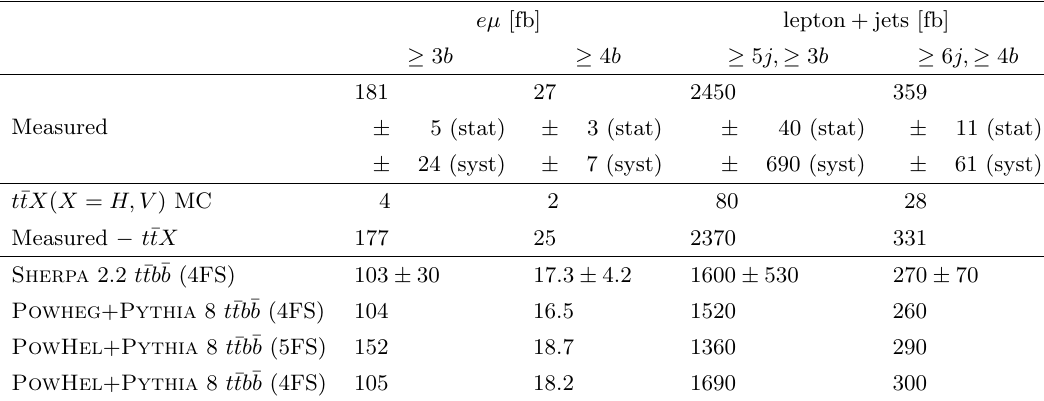
Table 5. Measured and predicted (cid:12)ducial cross-section results for additional b -jet production in the e(cid:22) and the lepton + jets decay channels.